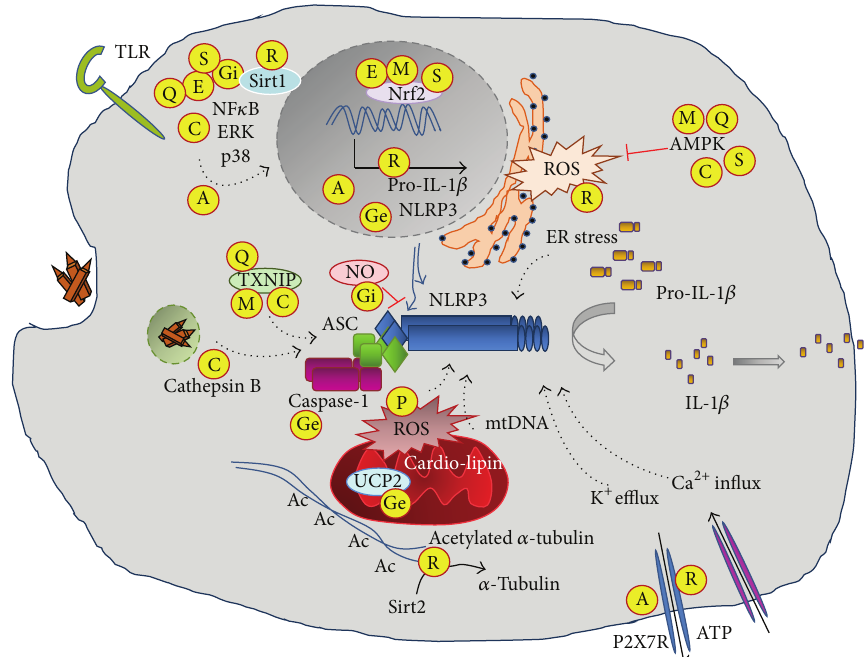
Figure 3: Molecular targets of natural compounds affecting NLRP3 inflammasome-mediated IL-1 production.